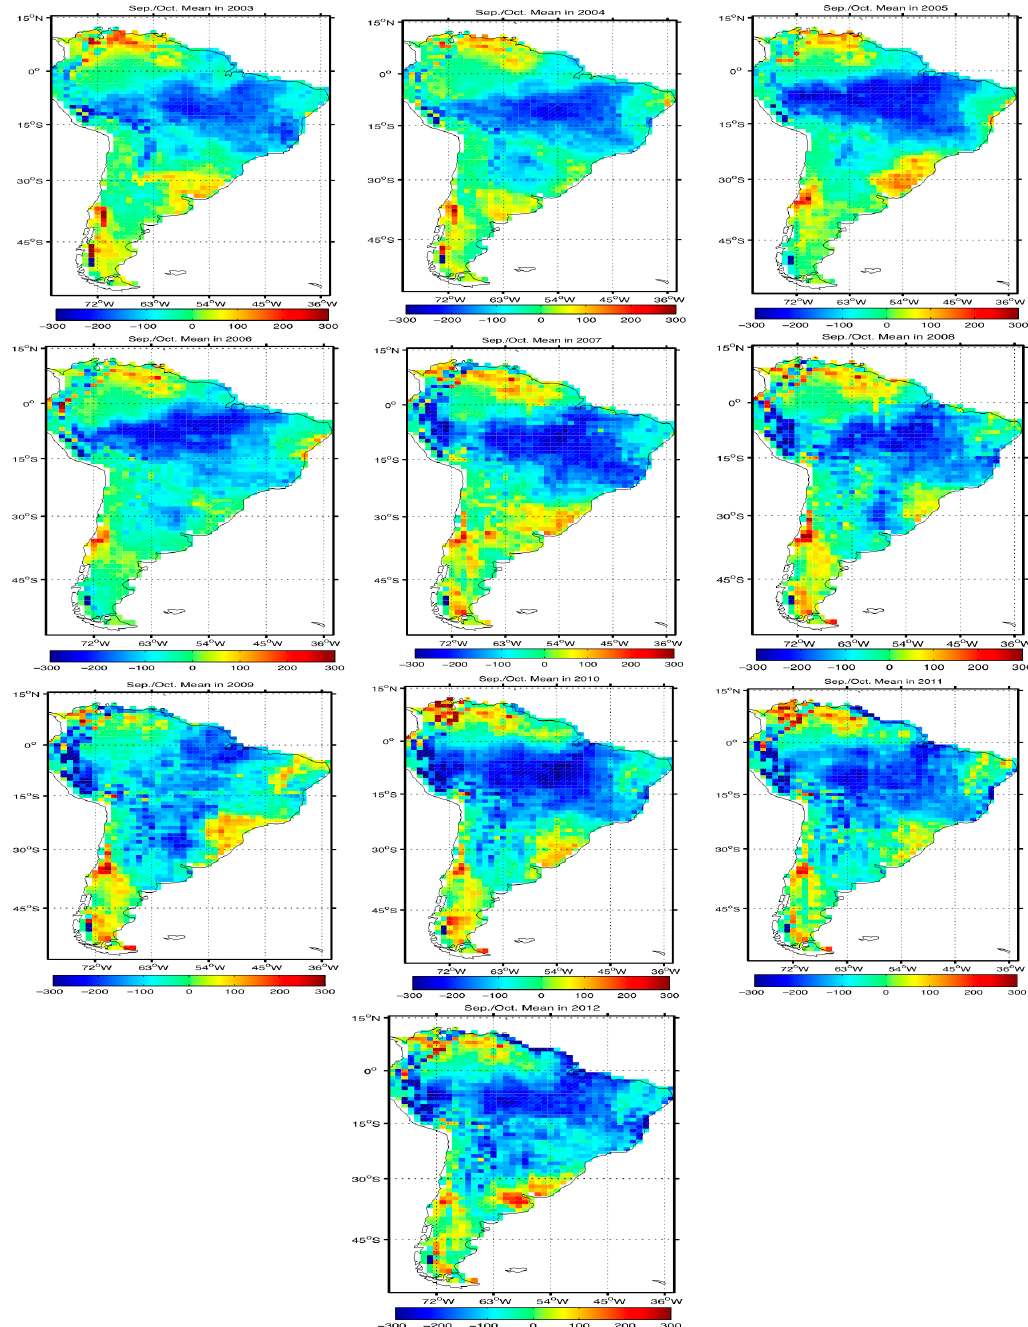
Figure 12. GLDAS-averaged September and October water storage changes (unit: mm) in the Amazon. From left to right and from top to bottom are years from 2003 to 2012 successively.